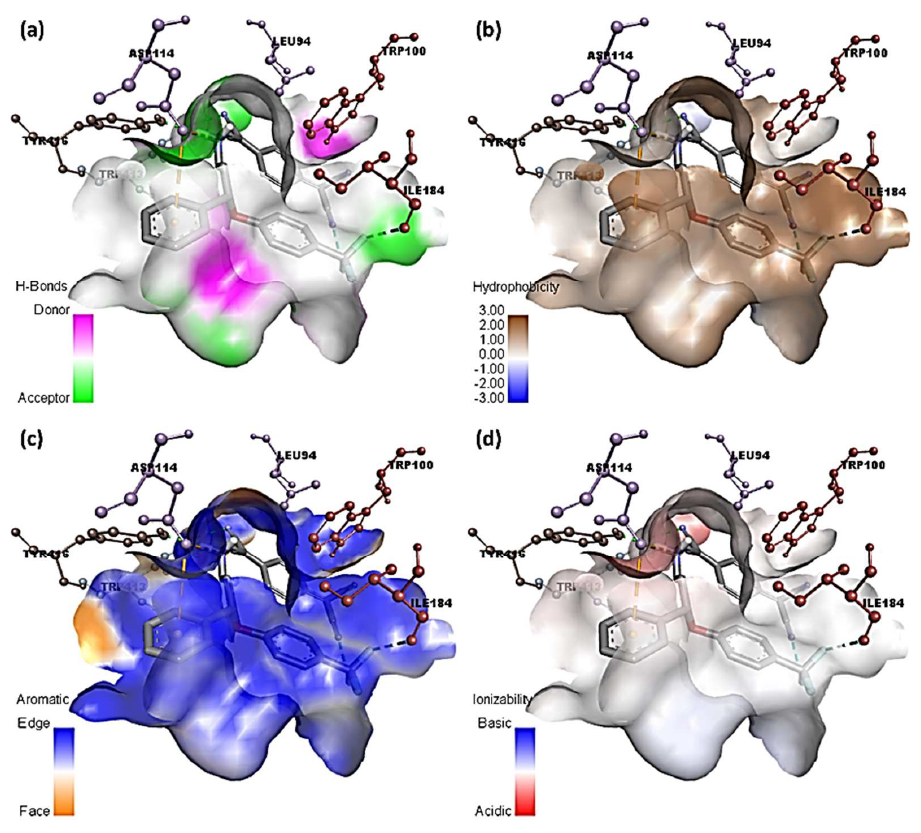
Figure 10. Representation of ( a ) hydrogen binding surface, ( b ) hydrophobic surface, ( c ) aromatic surface, and ( d ) ionizability surface; between dopamine and CT complex.